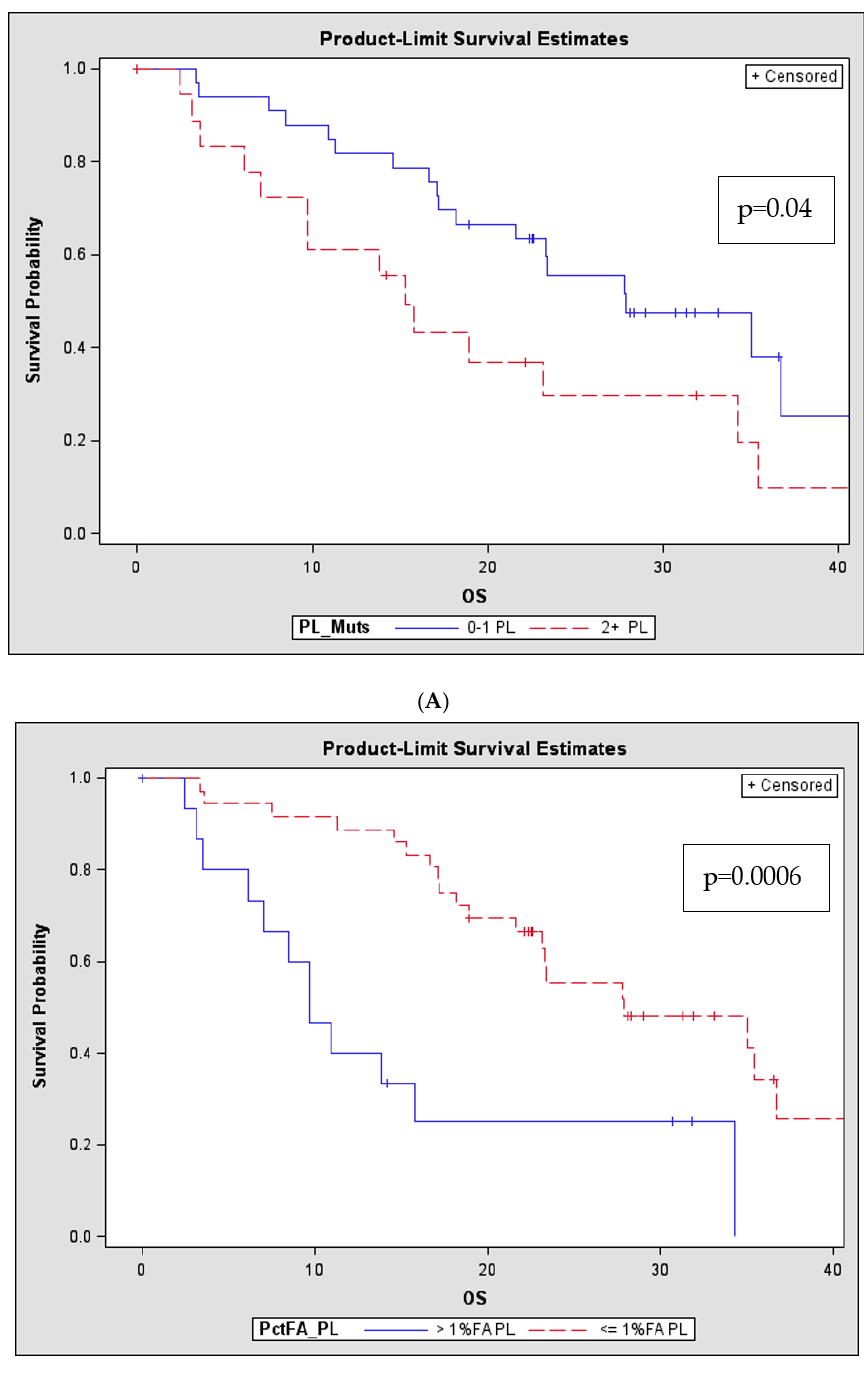
Figure 2. Number and mutational load of PL-mutations in advanced disease has prognostic implications in RR patients Kaplan-Meier (Product-Limit) OS curves and log-rank tests for RR patients ( n = 52) based on the number and FA of mutations in the PL determined through OMD analyses ( A ) Patients with 2 + PL mutations had significantly shorter OS compared to patients with 0–1 PL mutations ( p = 0.040) ( B ) The FA of the mutations represents the burden of the specific mutation in the designated compartment. Patients with >1% FA in the PL had significantly shorter OS compared to patients with lesser tumour burden in the PL (<1% FA; p < 0.001). (PL: plasma, RR: relapsed/refractory, OS: overall survival, FA: fractional abundance, OMD: OnTarget TM mutation